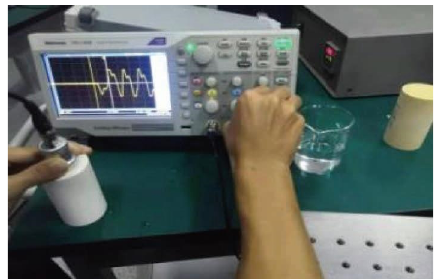
Figure 3: Acoustic measurement bulk modulus of elasticity.